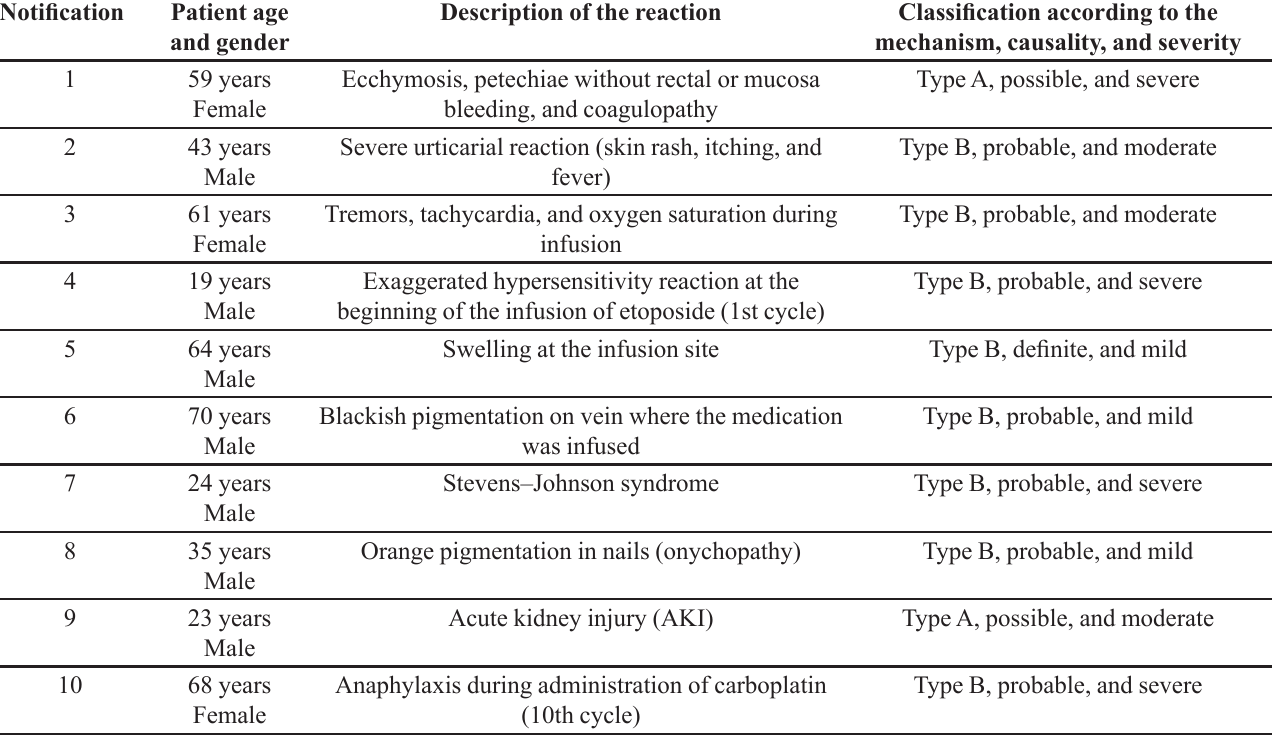
TABLE II - Description of spontaneous notifications of adverse drug reactions (ADRs) presented by oncology outpatients and inpatients from January to December 2010, Pharmacovigilance Sector (patient age; gender; description of the reaction; and classification according to the mechanism, causality, and severity)